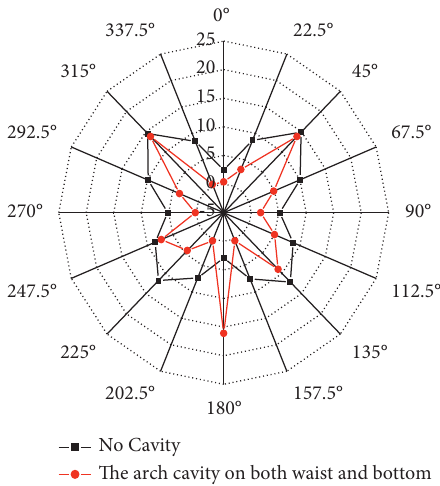
Figure 25: Safety coefficient of the segment cross section of arch waist and cavity behind the arch